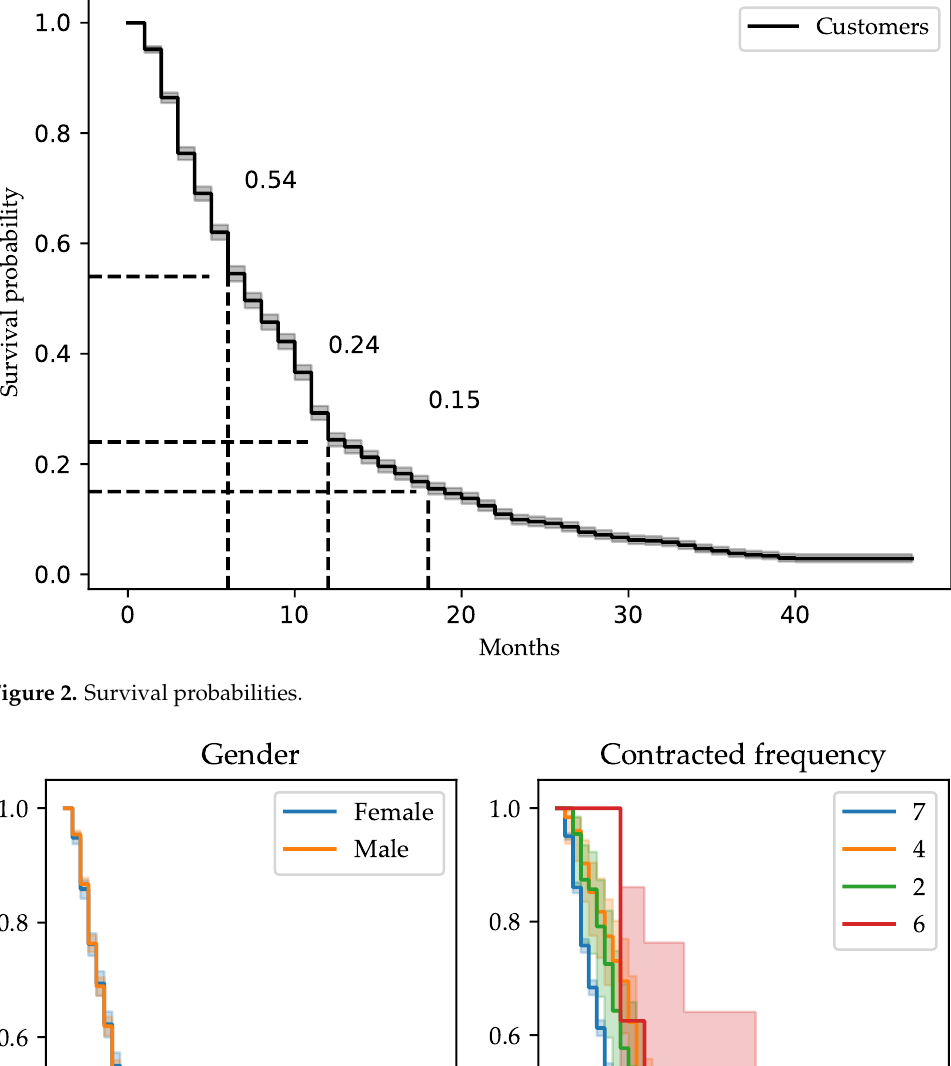
Figure 2. Survival probabilities.